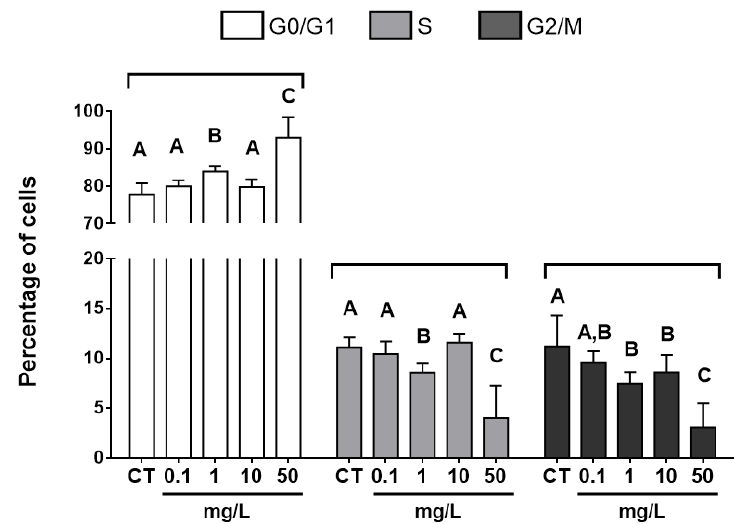
Figure 4. Cell-cycle distribution in G0 / G1, S and G2 / M phase analyzed from circulating erythrocytes of Xenopus laevis exposed to increasing concentrations of GO for 12 days. NC: negative control, N = 13, analysis of variance (ANOVA) p < 0.001 followed by Tukey test. Letters indicate significant differences between concentrations tested for each phase of the cell cycle.